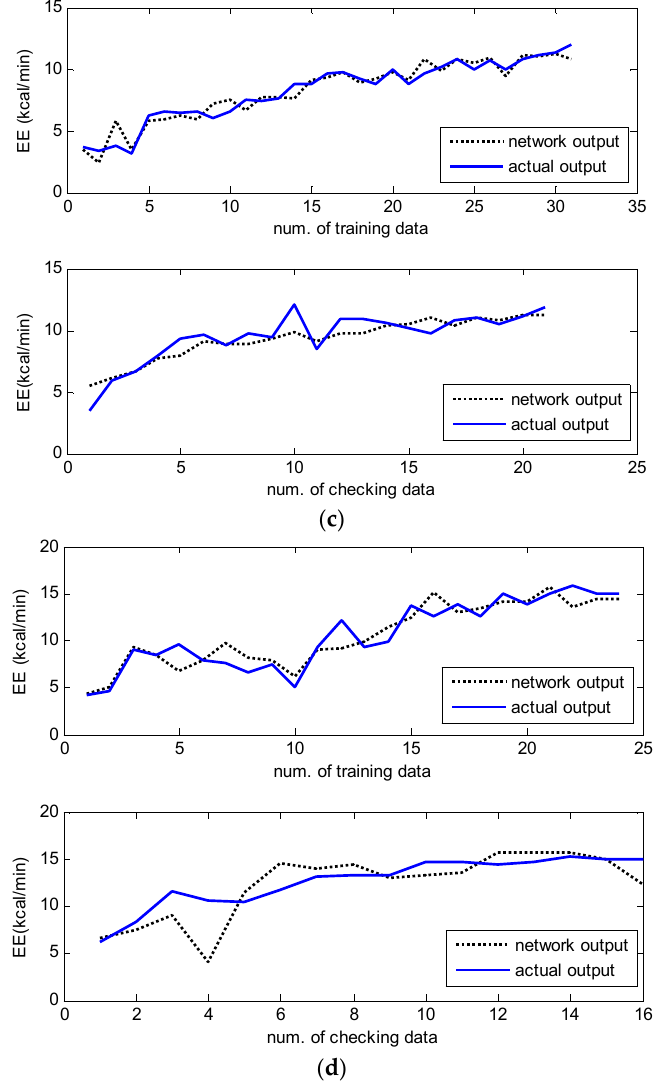
Figure 7. ( a – d ) Prediction performance of energy expenditure by the incremental RBFNN. ( a ) Normal walking in school playground; ( b ) Brisk walking in school playground; ( c ) Slow running in school playground; ( d ) Jogging in school playground. Table 4. Comparison of RMSE values for field exercise data.